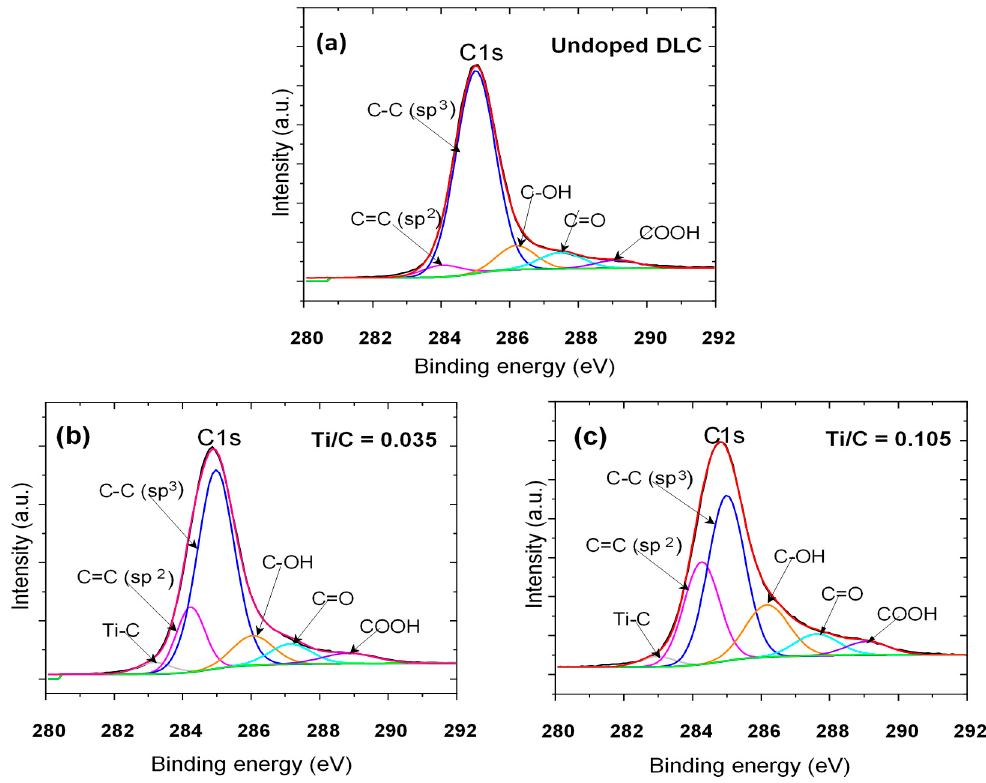
Figure 4. C1s X-ray photoelectron spectroscopy (XPS) spectra of ( a ) undoped DLC and Ti-DLC coatings: ( b ) Ti/C = 0.035 and ( c ) Ti/C = 0.105.